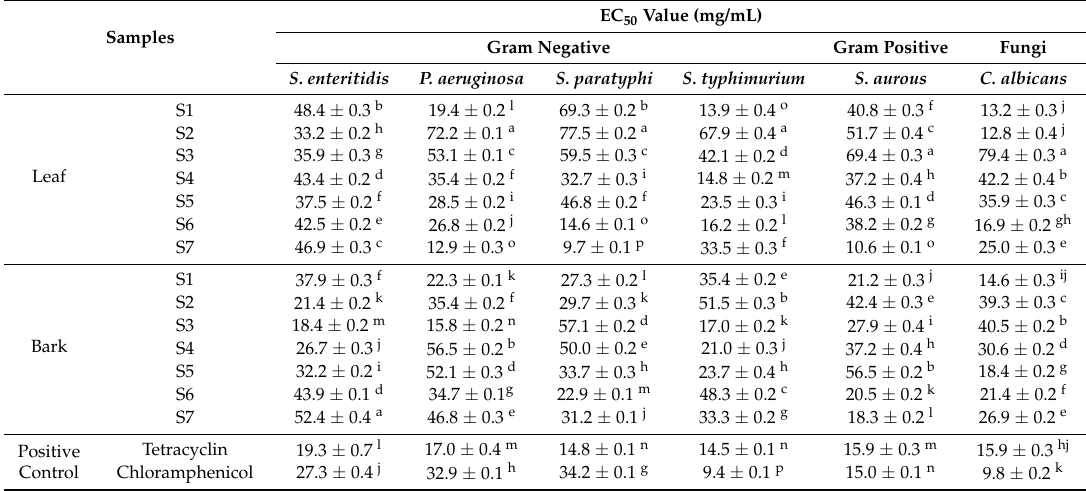
Table 6. EC 50 values of leaf and bark extracts of different E. ulmoides varieties against bacteria and fungi.